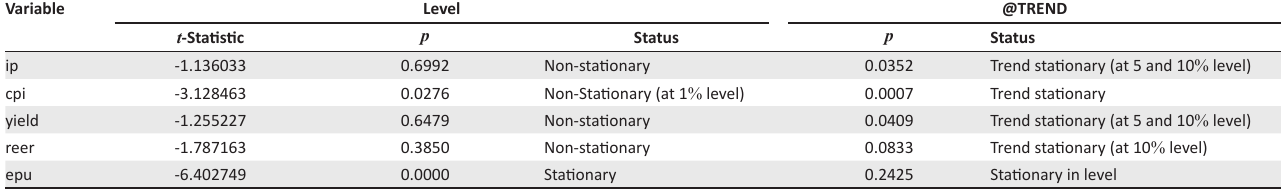
TABLE 2-A1: Augmented Dickey-Fuller unit root test on the variables analysed.